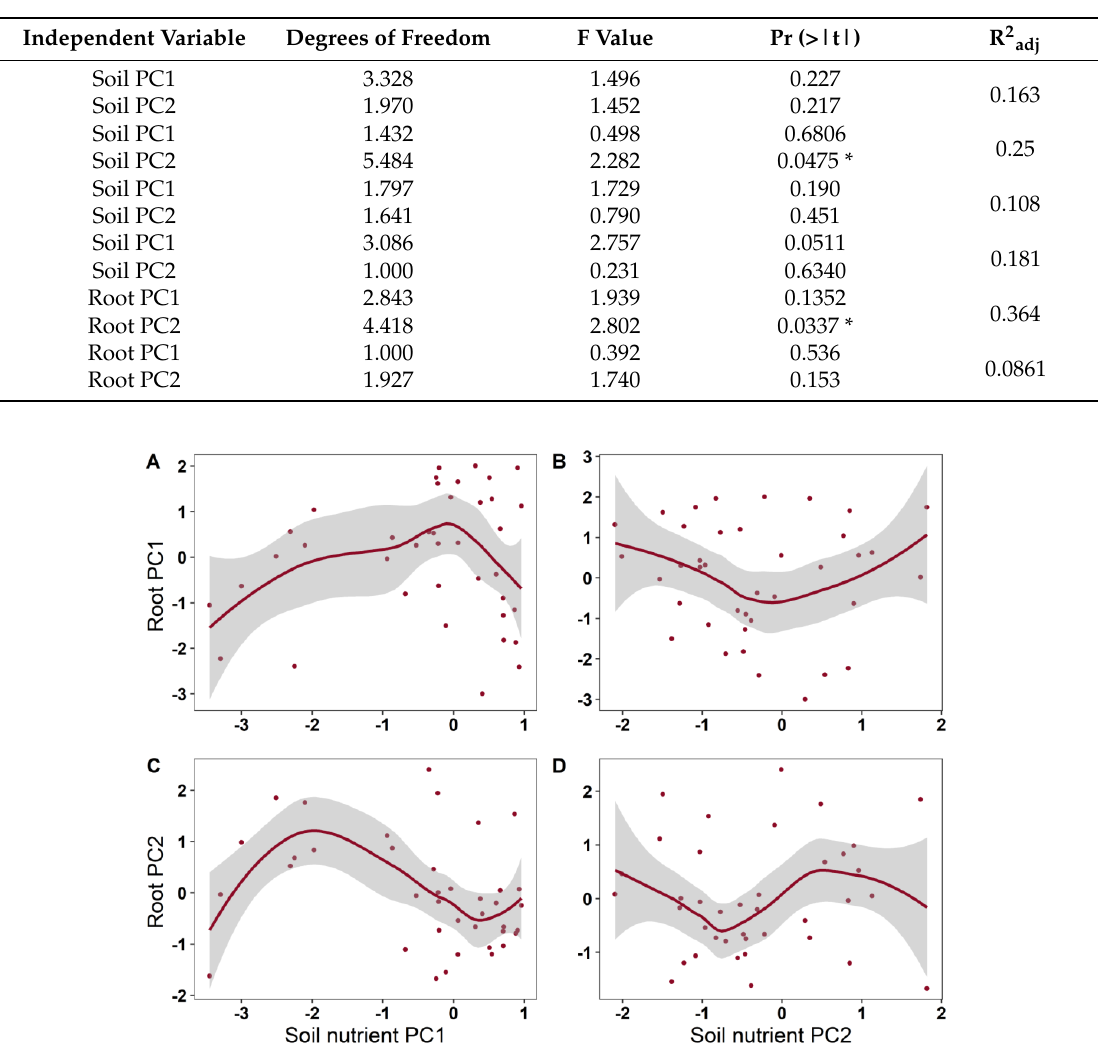
Table 2. Results of the generalized additive models (GAMs) explaining the influence of soil nutrient and root nutrient traits on leaf and root nutrient traits. * p < 0.05.